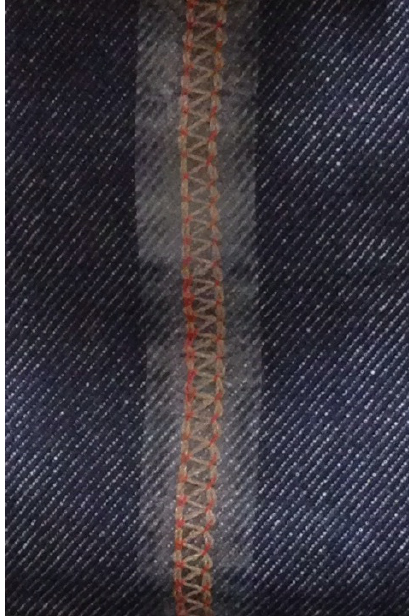
Figure 6. Insulation by fusing technique: a strip of bonding film is fused on the stitched